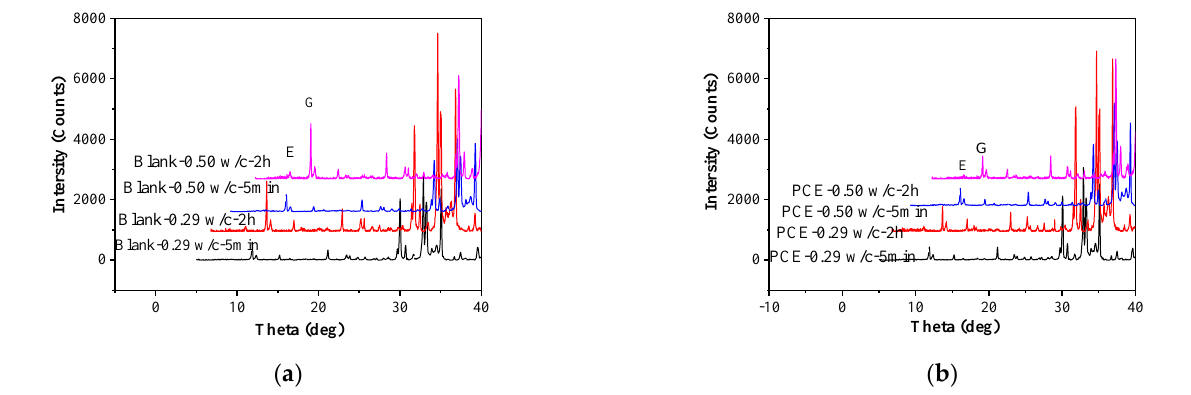
Figure 16. XRD spectra of the cement pastes at various w/c ratios with ( a ) and without PCE ( b ).